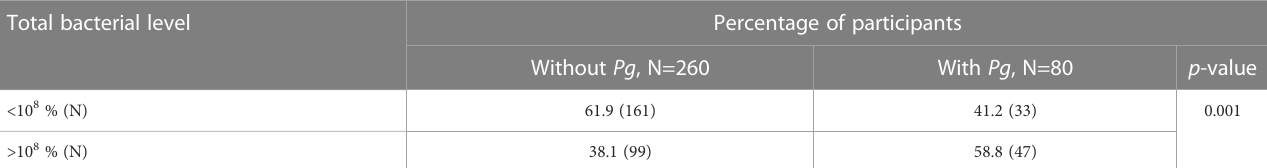
TABLE 6 Impact of P. gingivalis on bacterial bio fi lm formation. Total bacterial level